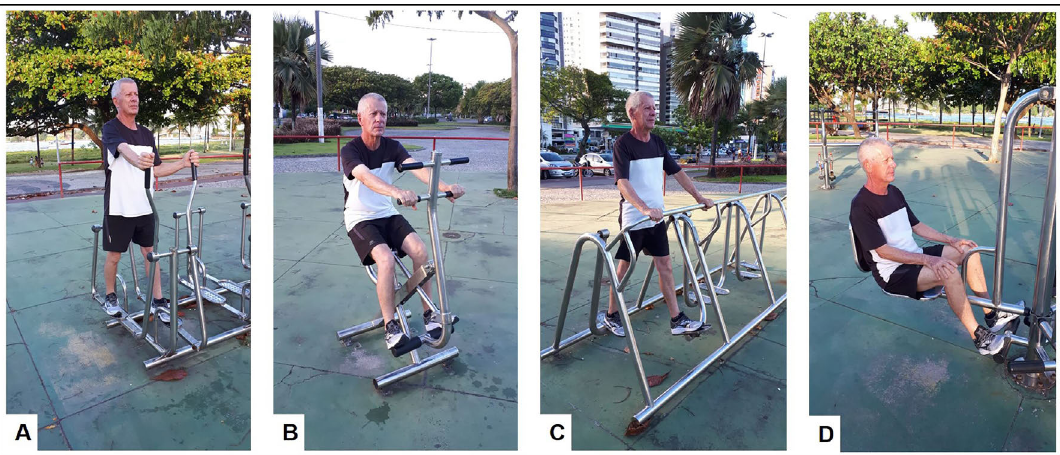
Figure 1 - Typical images representing the equipment used, including elliptical (Panel A), rowing (Panel B), surf/elliptical (Panel C), and leg press (Panel